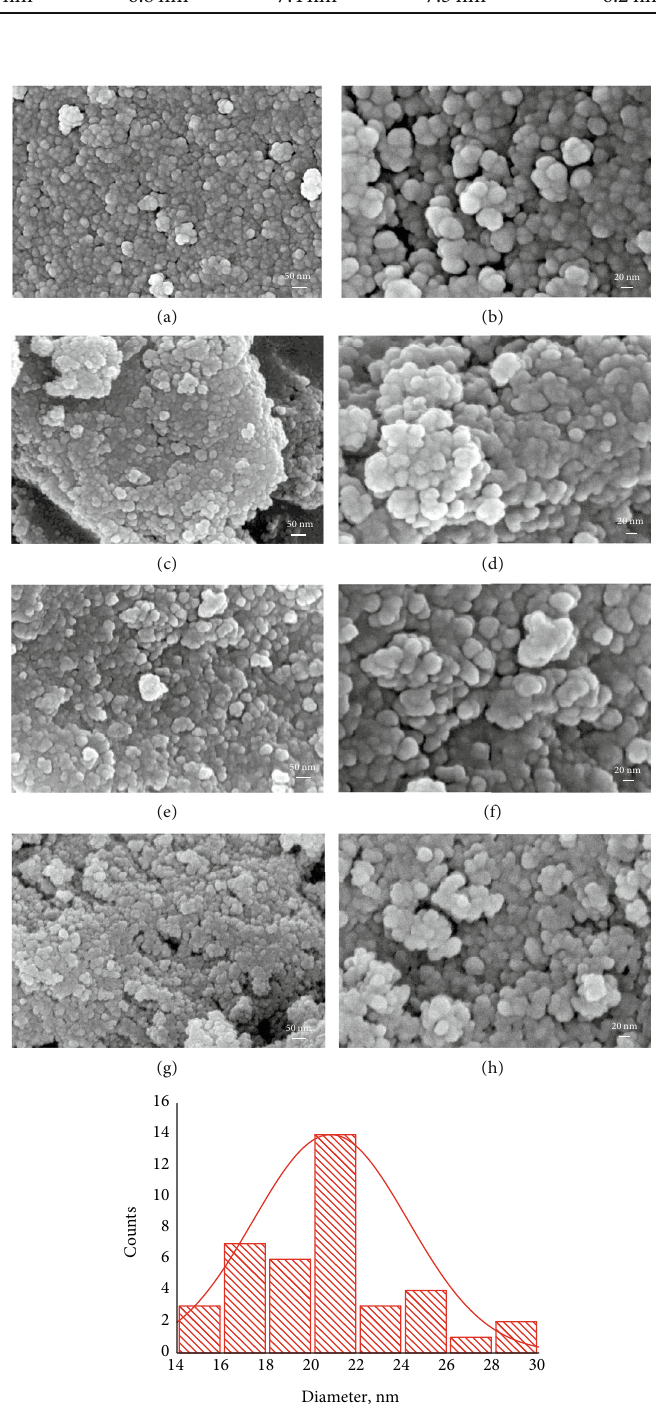
Figure 2: FE-SEM images of undoped TiO magni fi cations of 100k and 200 k. Inset shows a particle size distribution of TiO